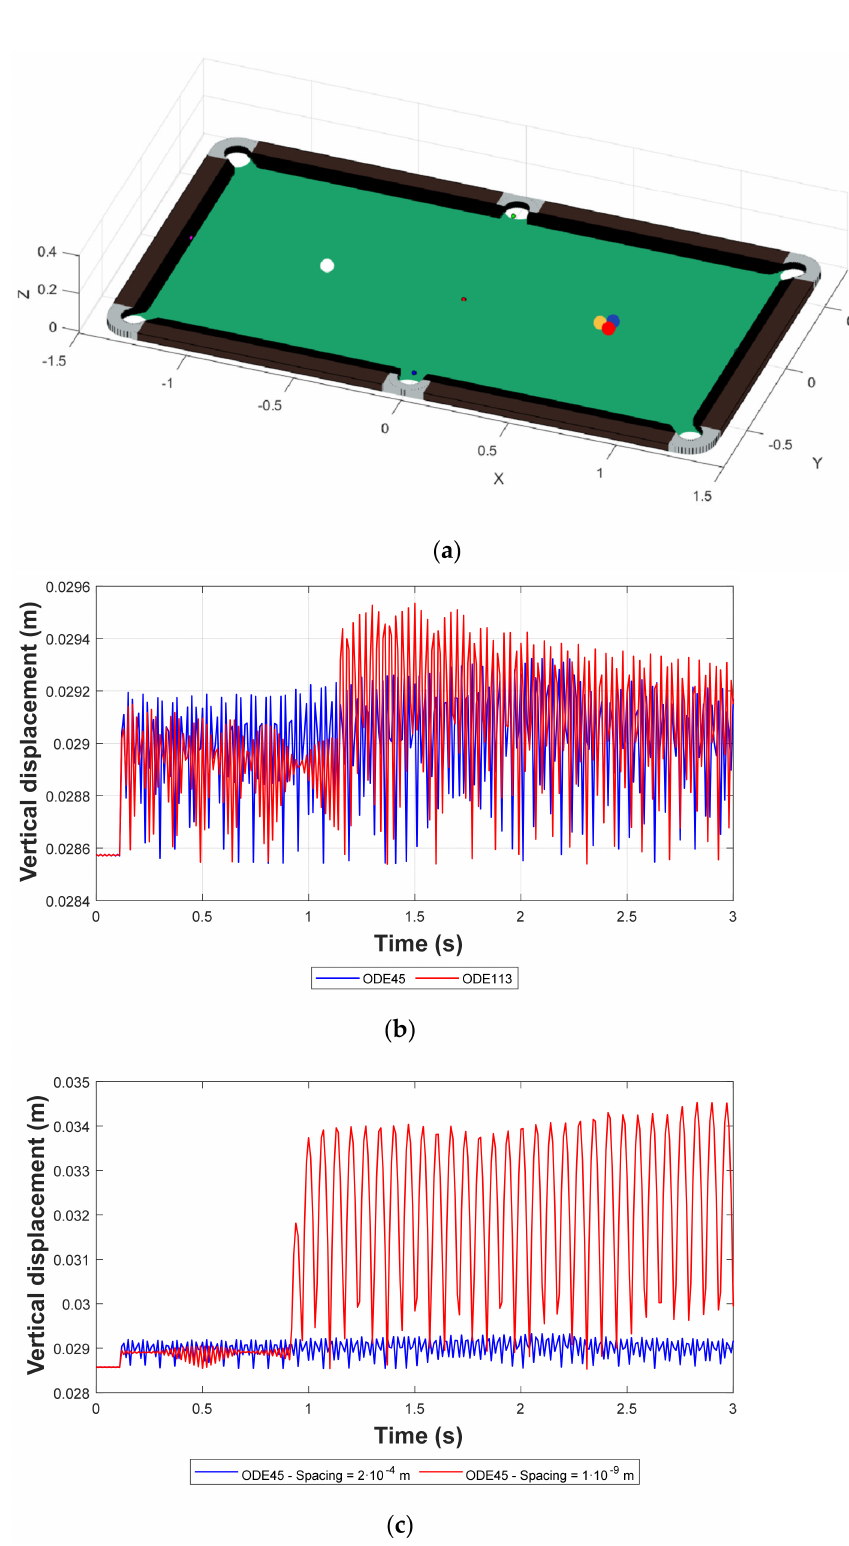
Figure 14. Practical application example of the algorithms described in Sections 3.1 and 3.2: ( a ) arrangement of the balls at t = 0 s; ( b ) evolution of z global coordinate of the cue ball as a function of the ODE integrators; ( c ) evolution of z global coordinate of the cue ball depending on the spacing between the balls of the